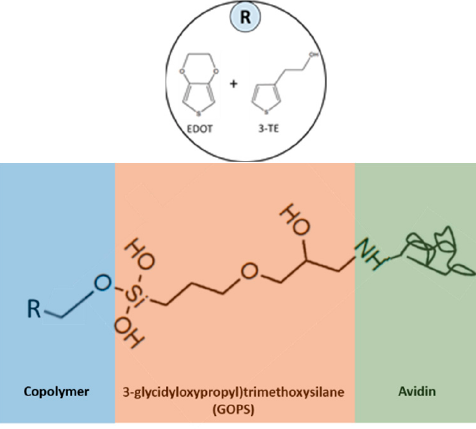
Figure 3. Avidin immobilization onto conducting polymer.